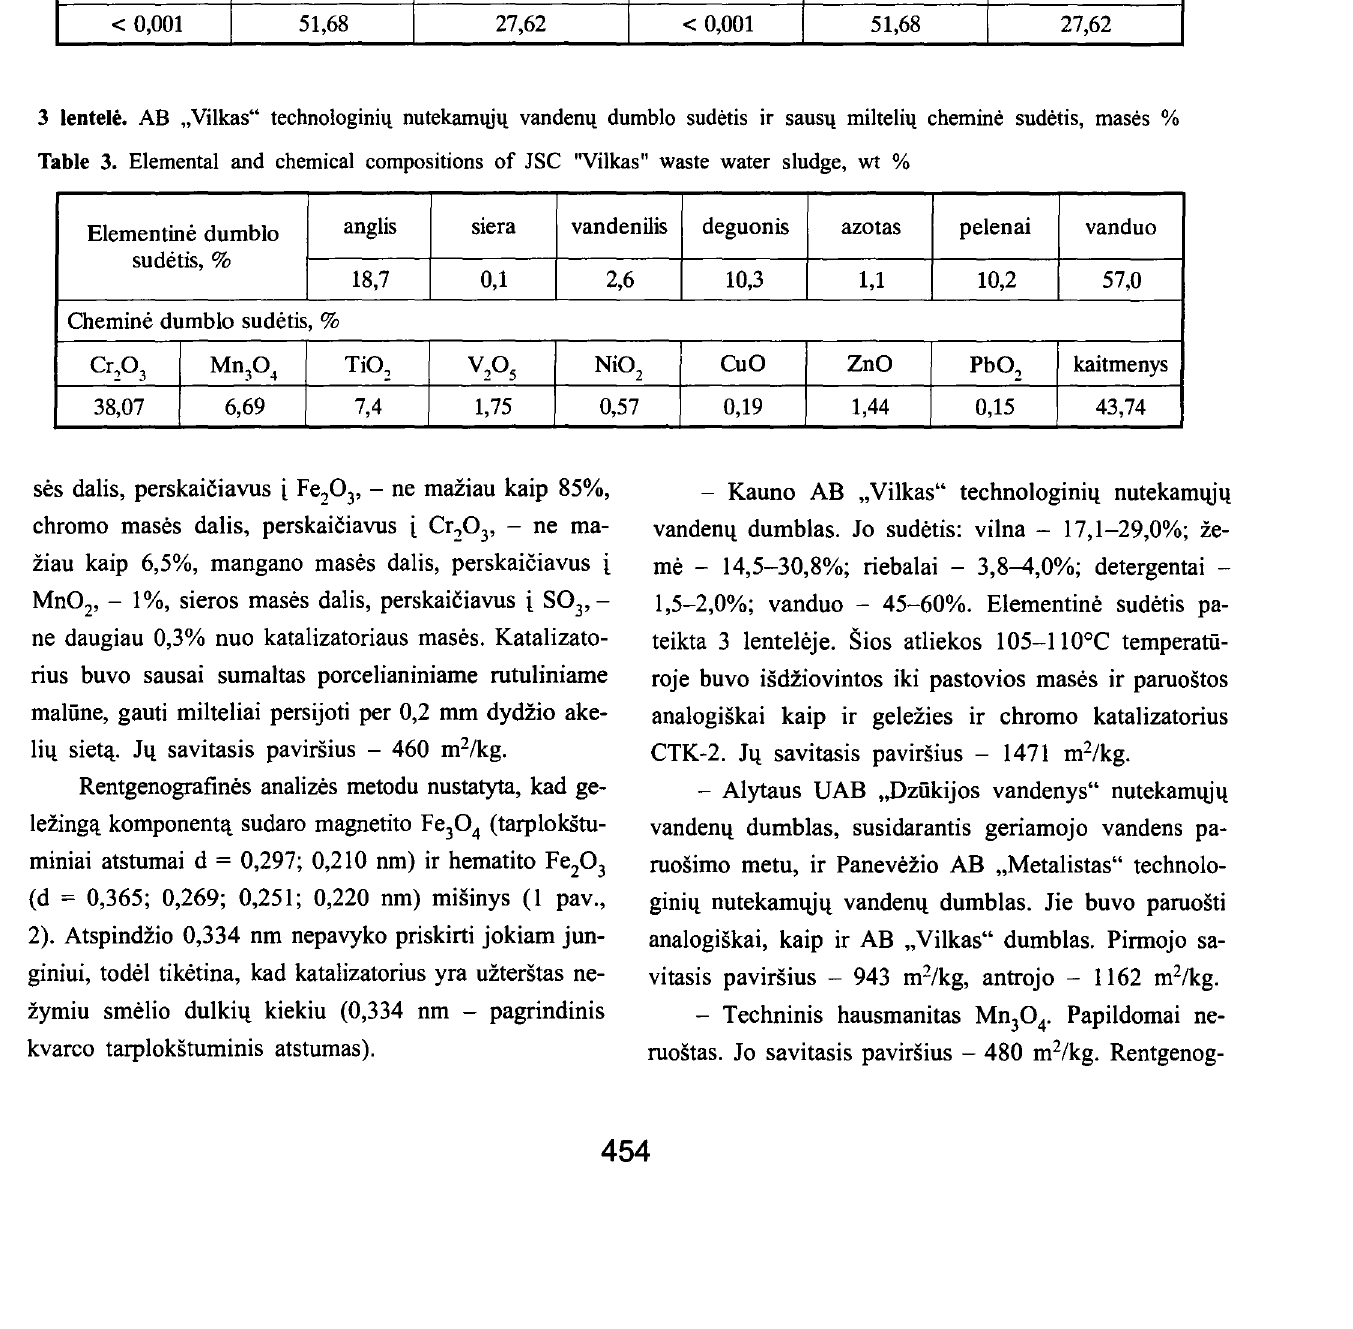
Table 3. Elemental and chemical compositions of JSC "Vilkas" waste water sludge, wt % Elementine